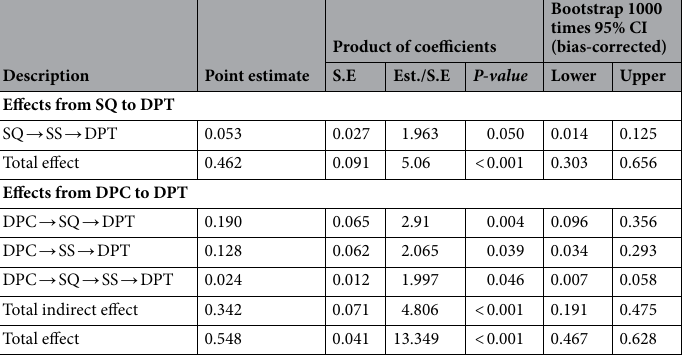
Table 5. Total and indirect effects of doctor–patient communication and service quality on doctor–patient trust. DPC doctor–patient communication, SQ service quality, SS service satisfaction, DPT doctor–patient trust, S.E. standard error, CI confidence interval, bootstrap =